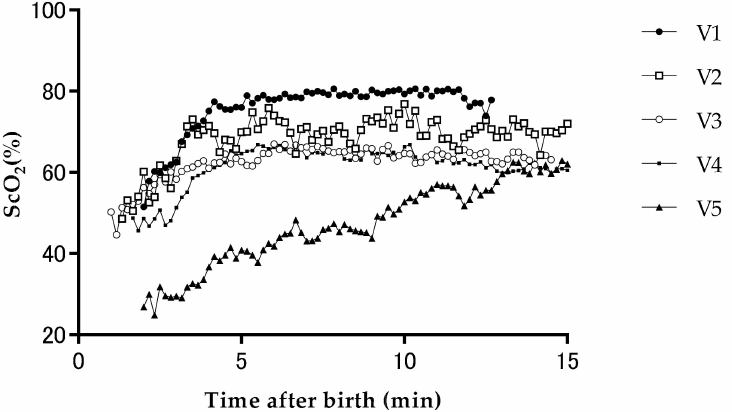
Figure 3. Cerebral hemoglobin oxygen saturation (ScO 2 ) in five neonates during the first 15 min of life. Values are means. ScO 2 showed the same pattern as arterial Hb oxygen saturation with a gradual increase, peak at 5–10 min, and then stable